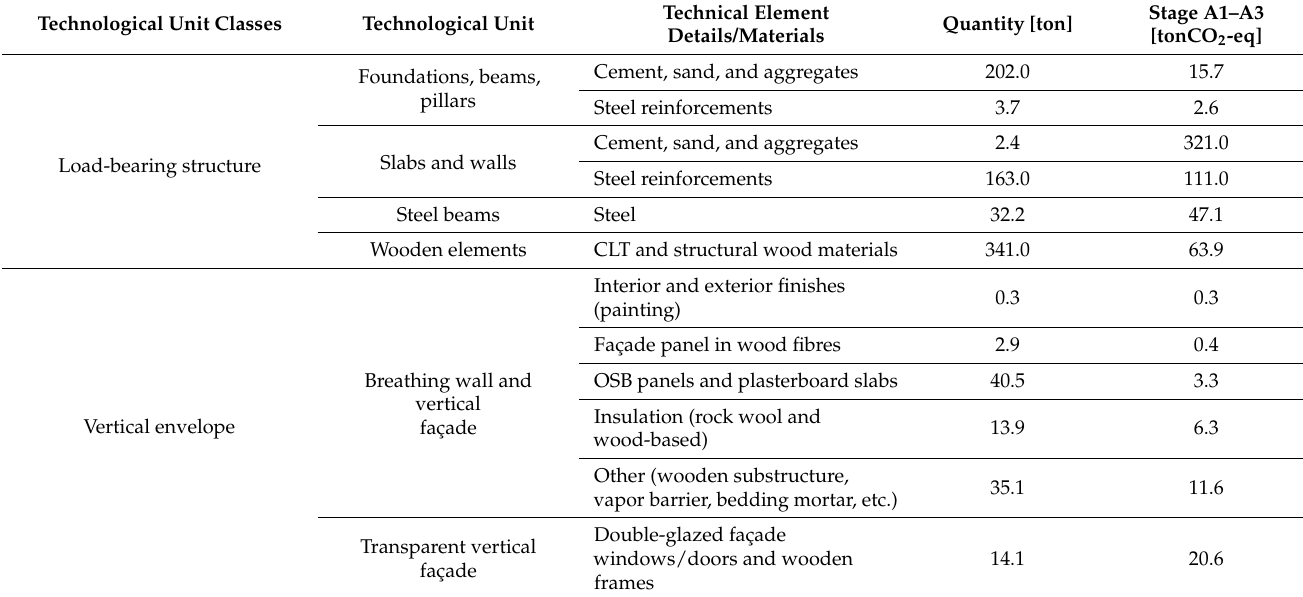
Table A5. Material construction phase impacts (A1–A3) for the CNB